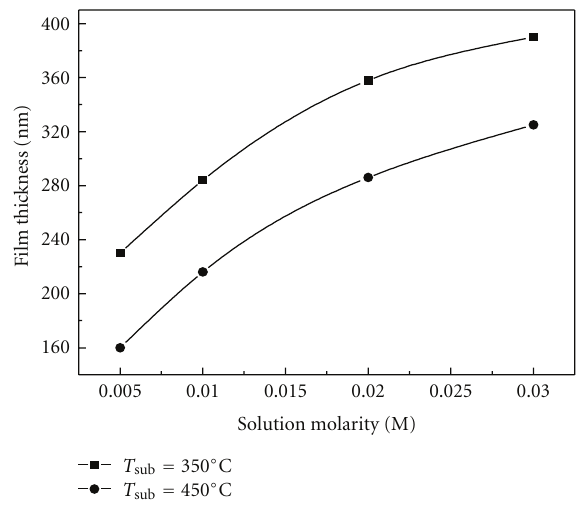
Figure 1: The thickness of IrO 2 films versus solution molarity prepared at substrate temperatures 350 ◦ C and 450 ◦